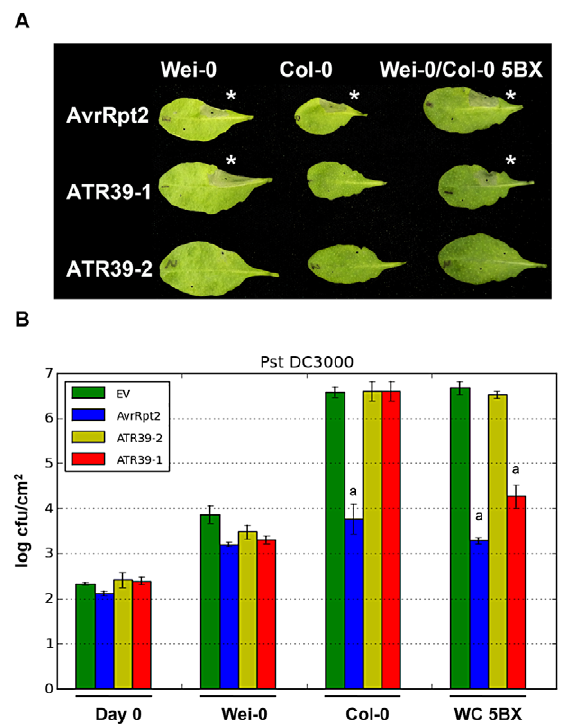
Figure 2. Hpa effector ATR39-1 is recognized by A. thaliana ecotype Wei-0. A) ATR39-1, but not ATR39-2, triggers a hypersensitive response (HR) in the Arabidopsis ecotype Weiningen (Wei-0) when delivered by Pf 0. The top half of the leaf was inoculated with the indicated effector, the bottom half with a negative GFP control. Wei-0 also contains a functional allele of RPS2 and AvrRpt2 was included as a positive control for HR. The picture was taken 24 hours post infection. Stars highlight induction of HR. B) ATR39-1 recognition inhibits growth of virulent Pst DC3000 in a Col-0 line where the RPP39 locus was introgressed (WC 5BX), while Wei-0 displays natural resistance towards Pst DC3000. Plants were inoculated with Pst DC3000 expressing the indicated effectors (10 5 cfu/mL) and bacterial titers determined 0 and 4 days post-infection. Error bars indicate standard deviation. Significant differences as determined by Student’s t-test are indicated by small letters (P , 0.0003). Experiments were repeated at least twice with similar